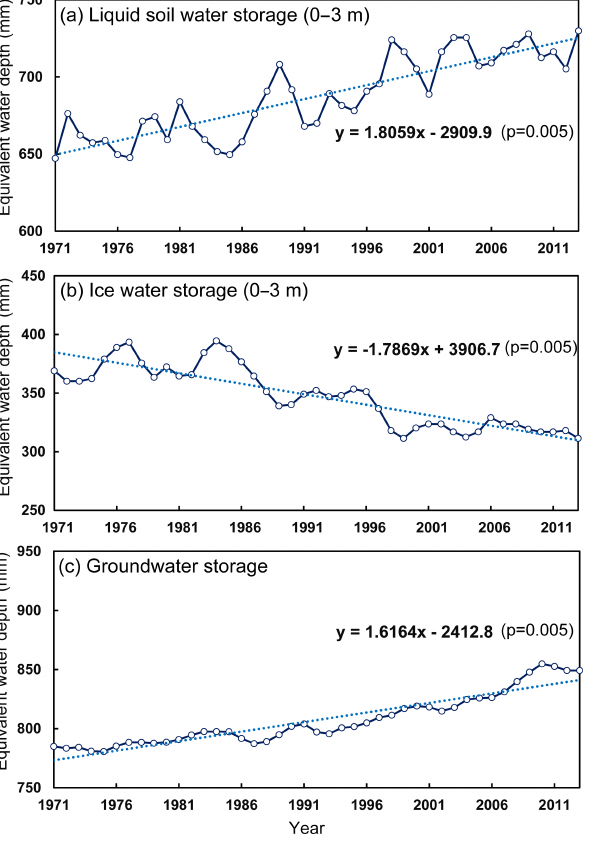
Figure 12. Basin-average annual water storage (equivalent water depth) changes simulated over the period of 1971 to 2013 for (a) liq- uid water in the top layer of the ground (0–3m), (b) ice in the top layer of the ground (0–3m), (c) and groundwater. Results from lin- ear regressions are